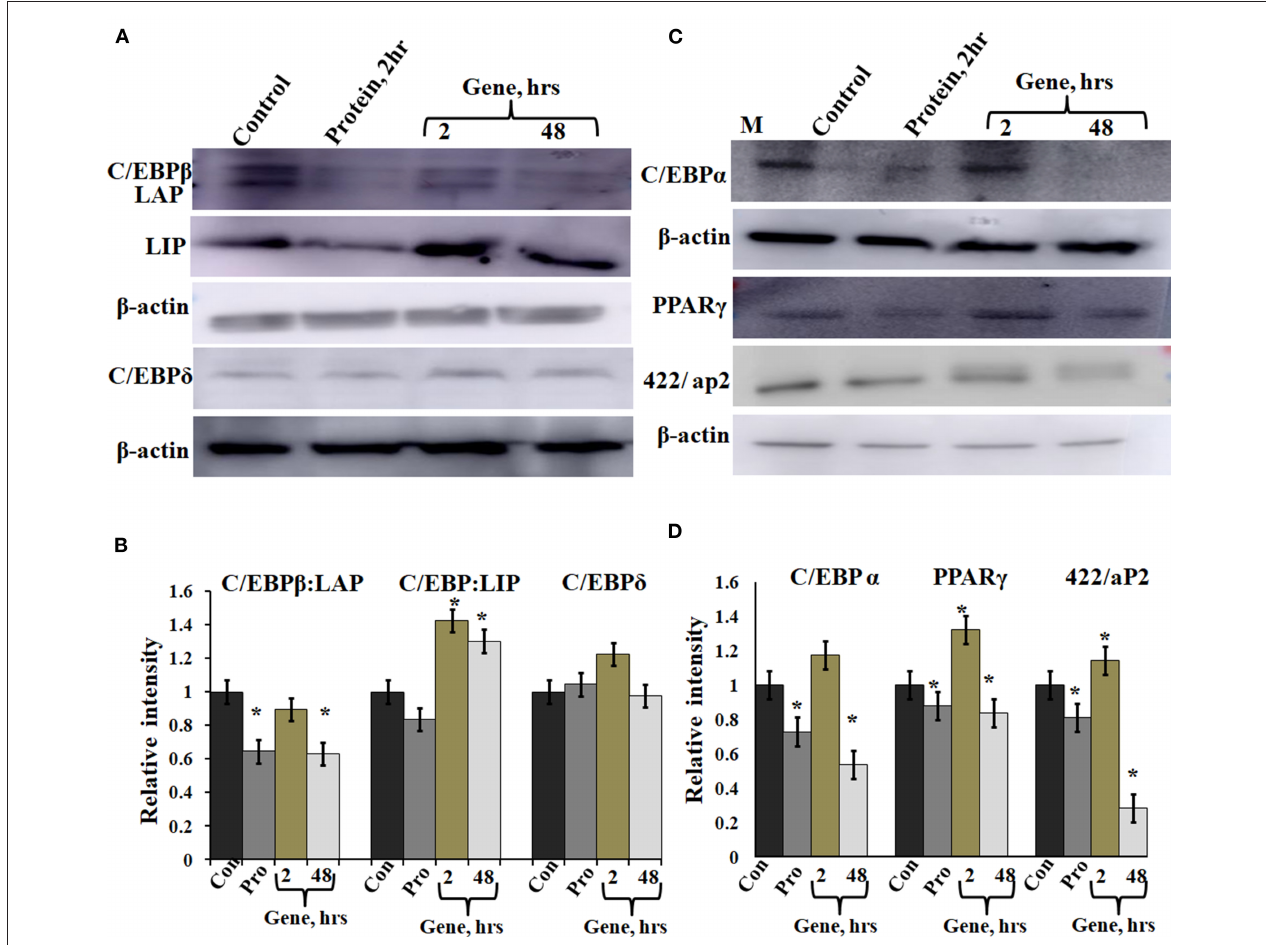
FIGURE 5 | Expression of C/EBP β , C/EBP δ , and adipocyte marker genes in cells transfected with A-C/EBP protein and gene. (A) Immunoblotting of C/EBP β (C/EBP β 35 kDa, LAP 32 kDa, and LIP 20 kDa) and C/EBP δ (30 kDa) from protein isolated from A-C/EBP protein- and gene-transfected cells. (B) Relative quantitative analysis of C/EBP β , LAP, and LIP isoforms and C/EBP δ w.r.t actin gene. (C) Immunoblotting of adipocyte markers C/EBP α (42 kDa), PPAR γ (53 and 57 kDa), and 422/aP2 (16 kDa) from protein- and gene-transfected cells. (D) Relative quantitative analysis of C/EBP α , PPAR γ , and 422/aP2w.r.t β -actin. *Significantly different from the control group ( p < 0.05). Values are expressed as mean ± SD; n = 3 independent